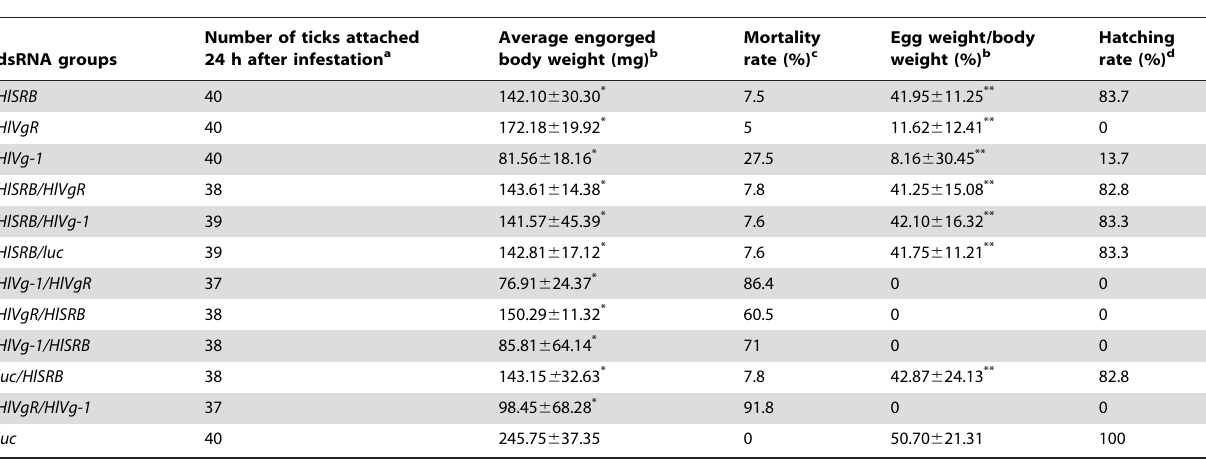
Table 2. Phenotypic changes of ticks injected with a single or a combination of different dsRNA(s).